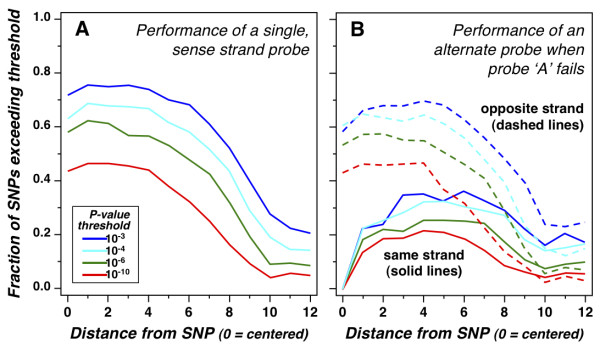
SNP detection performance. A, Performance of a single, sense strand probe: The ability of a single sense stranded probe overlapping a SNP to call the correct allele as a function of distance from the center of the probe to the SNP is shown. At a stringent P-value threshold of 10-4, approximately 65% of SNPs are called correctly using a probe centered exactly on the SNP (see haploid genotyping simulation section in Materials & Methods for a description of P-value calculations). B, Performance of an alternate probe when centered sense probe fails: When the centered probe fails to call the correct allele at a chosen threshold, the ability of one additional probe to rescue the call is shown as a function of strand and distance of the probe relative to the SNP. Probes on the sense strand at close distances to the SNP contribute little, presumably due to the same local constraints that caused the centered sense probe to fail, where as the opposite strand centered probe recovers 60% of missed calls at a threshold of 10-4. Therefore, at a threshold of 10-4, we achieve an 86% success rate.